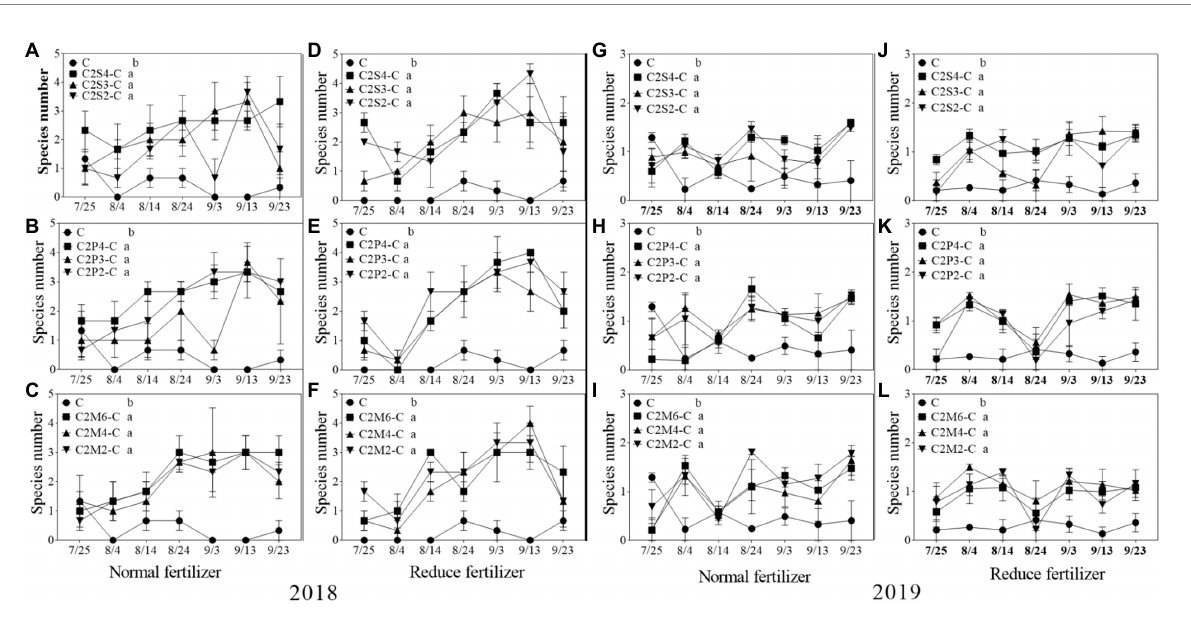
FIGURE 6 Species number ( S ) of natural enemy insect on corn plants intercropping with soybean, peanut and millet under different planting patterns at normal and reduced fertilizer. A-C represent corn-soybean intercropping, corn-peanut intercropping and corn-millet intercropping under normal fertilizer in 2018, respectively. D-F represent corn- soybean intercropping, corn-peanut intercropping and corn-millet intercropping under fertilizer reduction in 2018, respectively. G-I represents corn-soybean intercropping, corn-peanut intercropping and corn-millet intercropping under normal fertilizer in 2019, respectively. J-L represent corn-soybean intercropping, corn- peanut intercropping and corn-millet intercropping under fertilizer reduction in 2019, respectively. C2S2-C, C2S3-C, C2S4-C: corn plants in the planting patterns of 2 corn rows intercropping with 2, 3, 4 rows of soybean; C2P2-C, C2P3-C, C2P4-C: corn plants in the planting patterns of 2 corn rows intercropping with 2, 3, 4 rows of peanut; C2M2-C, C2M4-C, C2M6-C: corn plants in the planting patterns of 2 corn rows intercropping with 2, 4, 6 rows of millet. Different lowercase represents a significantly different average of the 7 evaluations among different planting patterns at the same fertilizer level and the same intercropping type by the LSD test at p < 0.05,